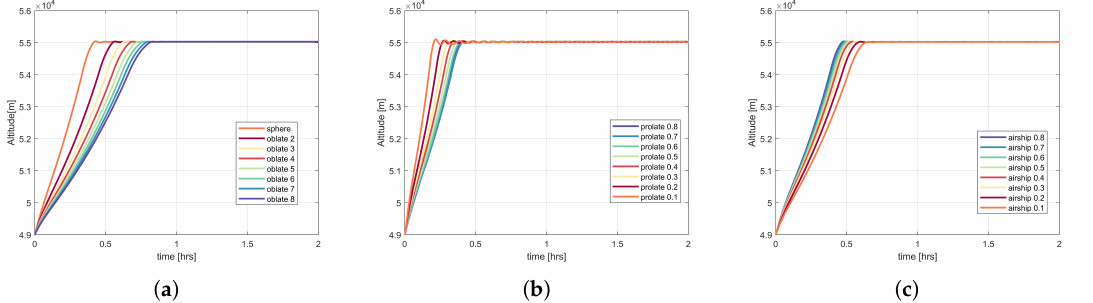
Figure 7. Altitude variation of the OZP balloons for different shapes with varying fineness ratios f in order to find the stable fineness ratio on Venus ( a ) oblate ( f : 2–8) ( b ) prolate (0.1–0.8) ( c ) airship